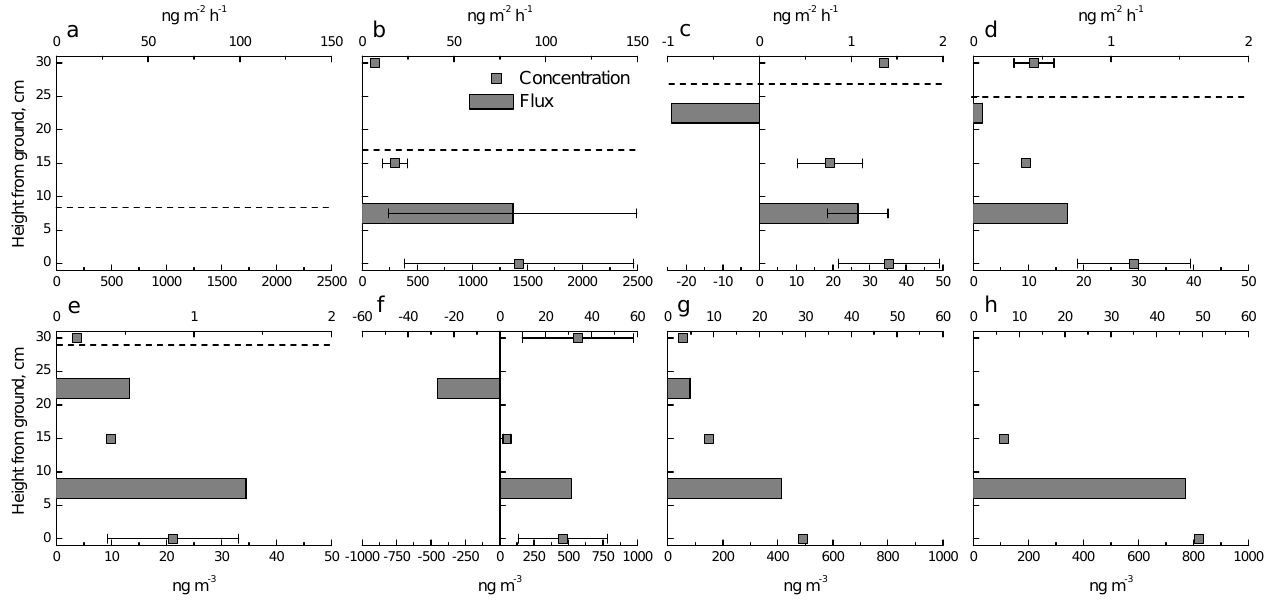
Fig. 4. Total sesquiterpene concentrations and estimated fluxes in the snowpack during sampling dates (a) 27 November 2008, (b) 5 Febru- bars (if more than two values) represent standard error of the tree collectors. 0cm represents the soil surface and dashed horizontal line the snowpack depth, if it was below 30cm. Data of two damaged profiles were omitted from sampling days 2 February 2010 and 1 March